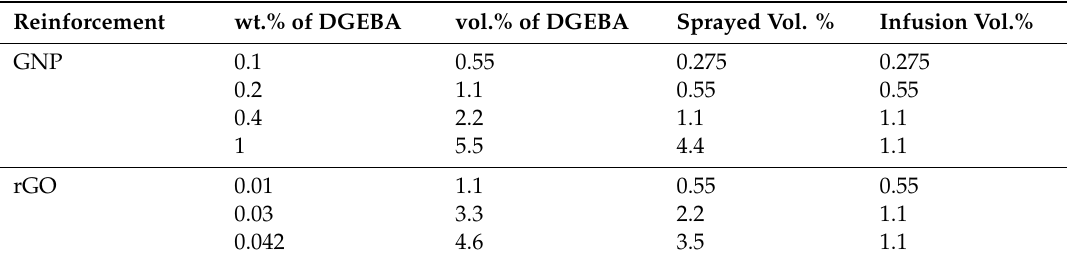
Table 2. Amount of nanoparticle used for sizing and infusion of fiberglass / epoxy composites. Reinforcement wt.% of DGEBA vol.% of DGEBA